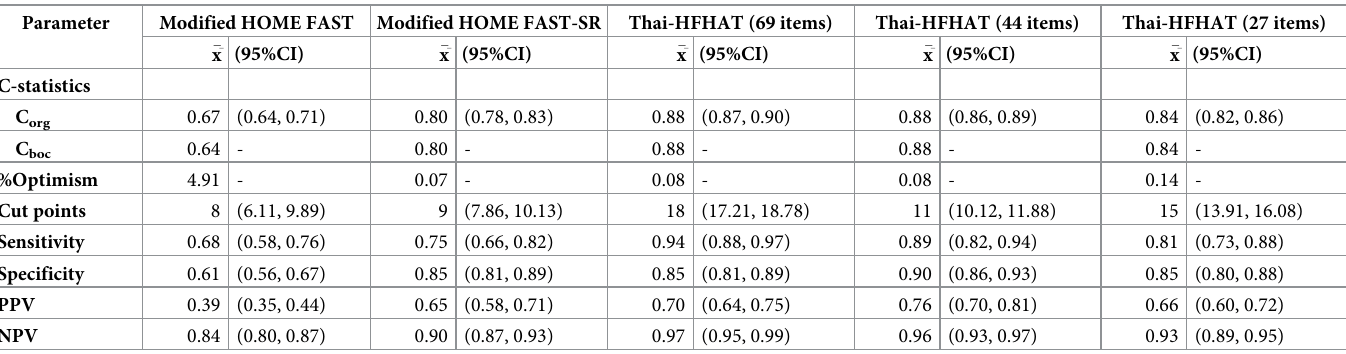
Table 3. Predictive validity of five home fall hazard assessment tools.